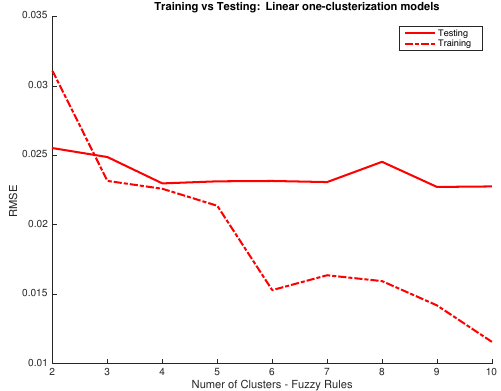
Figure 5. RMSE between predictions from the FIS system using the same clusterization for all inputs and linear activation functions and desired outputs in the CIEXYZ training and testing datasets (y axis) vs. number of clusters used (x axis).